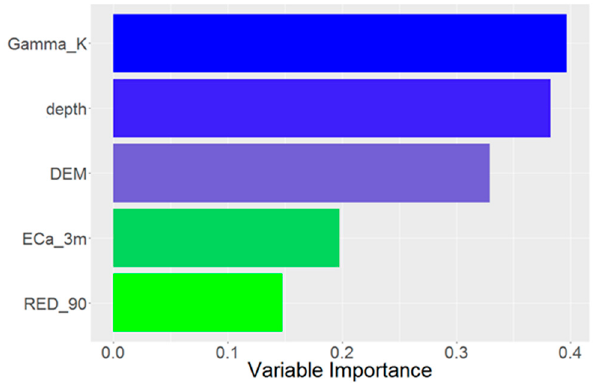
Figure 8. Mean decrease in accuracy showing the predictor variable importance in predicting soil pH.